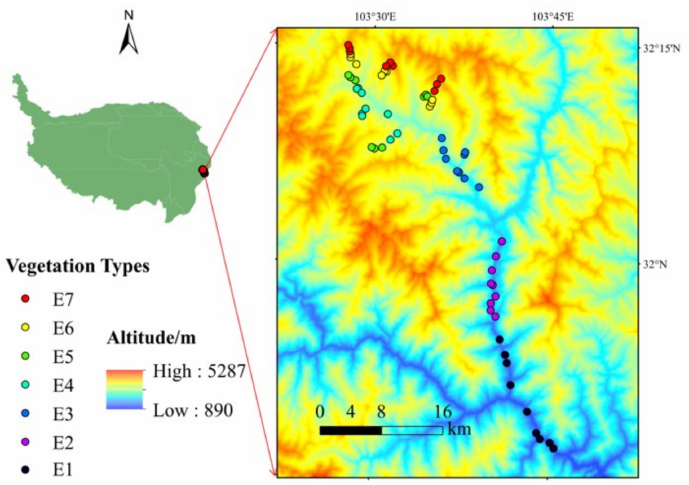
Figure 1. The sampling sites along altitude gradients of the study area on the eastern Qinghai–Tibetan